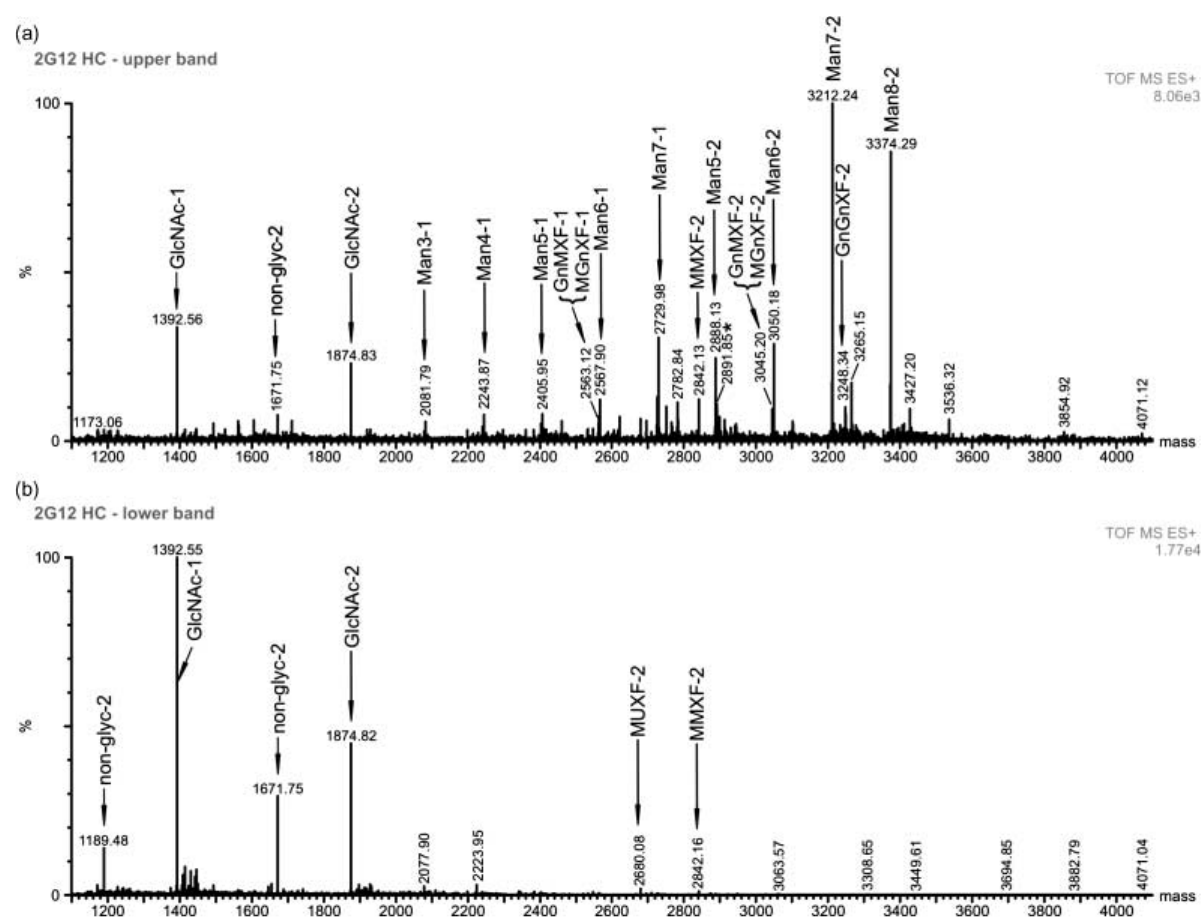
Figure 7 Deconvoluted liquid chromatography-mass spectra of glycosylated peptides (-1, EEQY N STYR; -2, TKPREEQY N STYR) containing asparagine-297 (Asn-297) from the 2G12 Fc region. (a) Glycopeptides derived from the 2G12 heavy chain (HC) upper band. (b) Glycopeptides derived from the 2G12 HC lower band. See http://www.proglycan.com for an explanation of N -glycan structure